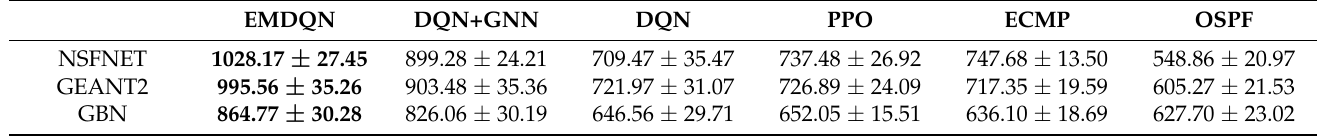
Table 3. A comparison of the average throughput of each algorithm in different